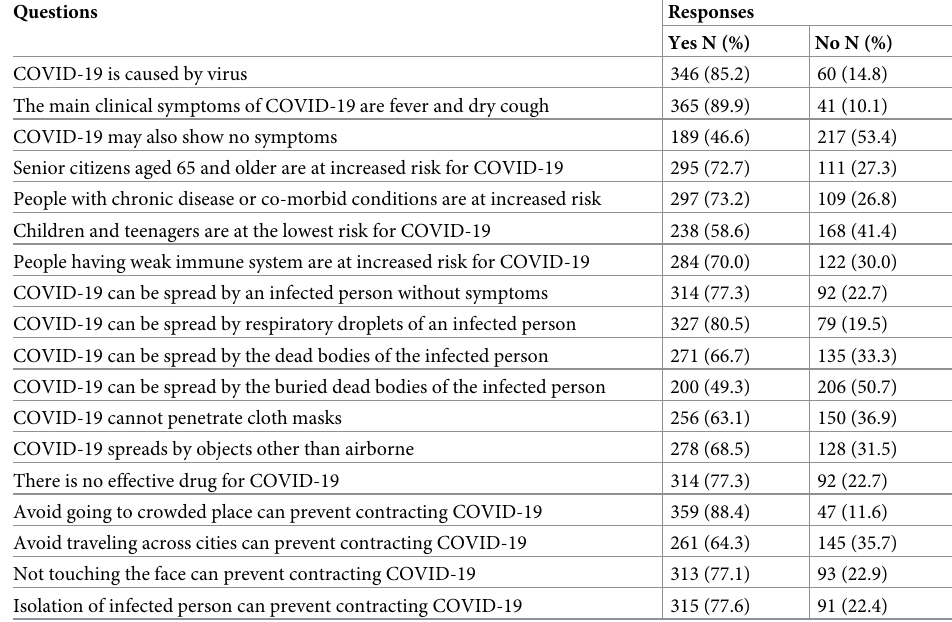
Table 2. Response to knowledge questions among preparatory school students at Mizan-Aman town, 2021 (n = 406).